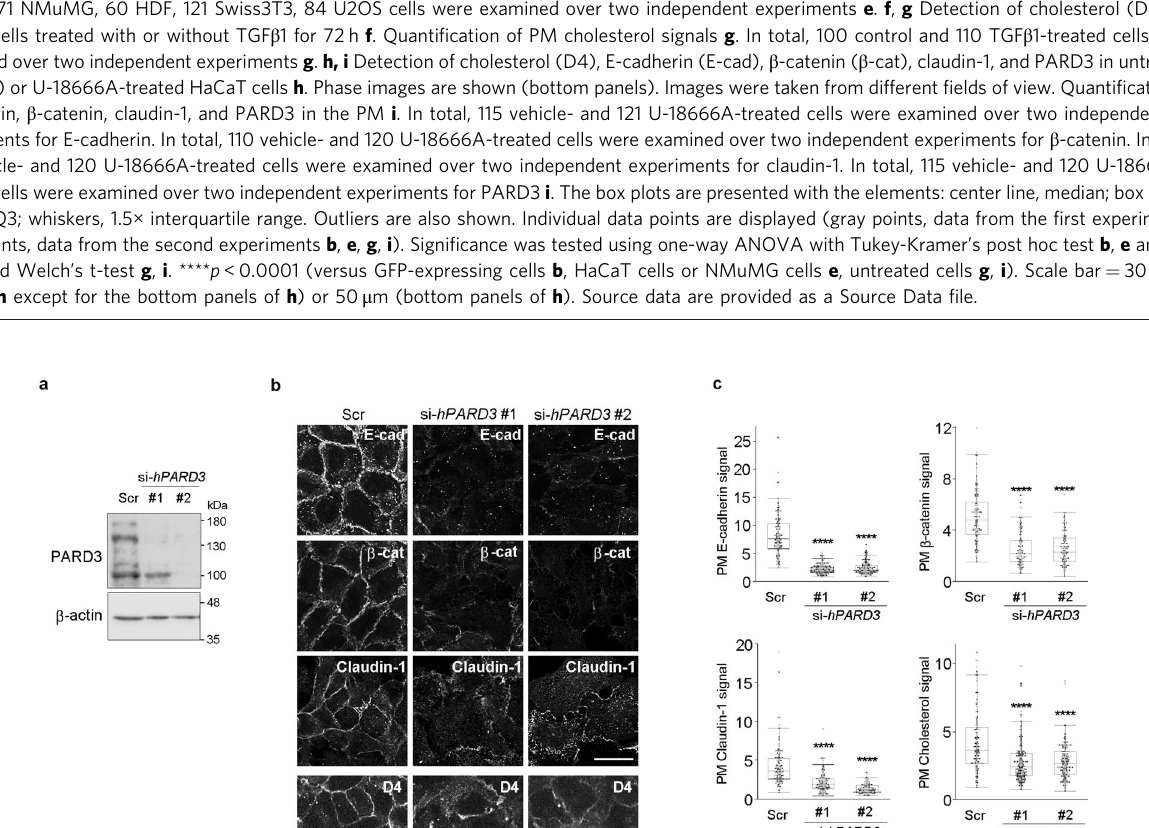
Fig. 6 Plasma membrane PARD3 regulates epithelial characteristics. a Immunoblotting for PARD3 in HaCaT cells treated with scrambled (Scr) or PARD3 -targeting (PARD3#1 and #2) siRNAs. 180 kDa, 150 kDa, and 100 KDa forms of PARD3 were detected. β -actin was used as the loading control. Immunoblot data shown were representative of two independent experiments with similar results. b , c Detection of E-cadherin (E-cad), β -catenin ( β -cat), claudin-1, and cholesterol (D4) in HaCaT cells treated with scrambled (Scr) or PARD3 -targeting (PARD3#1 and #2) siRNAs b . Images were taken from different fi elds of view. Quanti fi cation of the plasma membrane (PM) signals of E-cadherin, β -catenin, claudin-1, and cholesterol c . In total, 103 Scr, 119 PARD3#1, and 111 PARD3#2 cells were examined over two independent experiments for E-cadherin. In total, 125 Scr, 104 PARD3#1, and 107 PARD3#2 cells were examined over two independent experiments for β -catenin. In total, 113 Scr, 113 PARD3#1, and 102 PARD3#2 cells were examined over two independent experiments for claudin-1. In total, 114 Scr, 152 PARD3#1, and 136 PARD3#2 cells were examined over two independent experiments for cholesterol c . The box plots are presented with the elements: center line, median; box limits, Q1 and Q3; whiskers, 1.5× interquartile range. Outliers are also shown. Individual data points are displayed (gray points, data from the fi rst experiments; black points, data from the second experiments). Signi fi cance was tested using one-way ANOVA with Tukey-Kramer ’ s post hoc test. **** p < 0.0001 (versus HaCaT cells treated with scrambled siRNA). Scale bar = 30 μ m b . Source data are provided as a Source Data fi